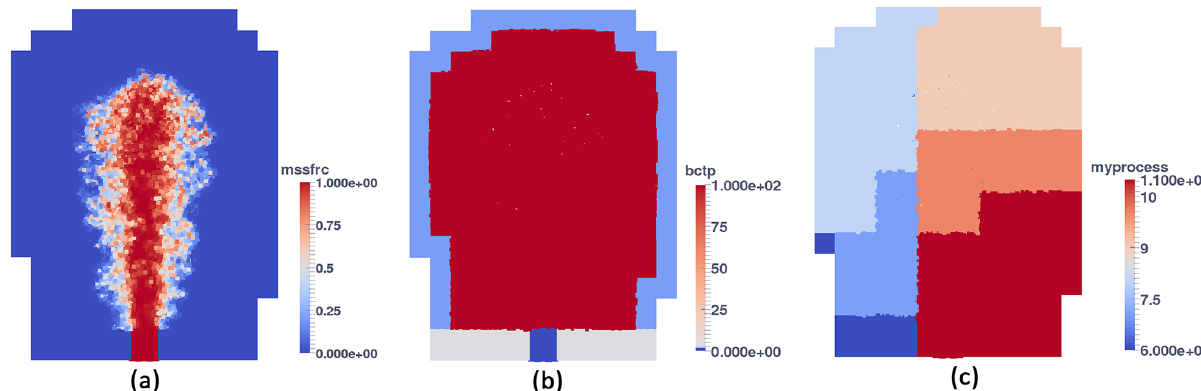
Figure 2. A cross-section view of the simulation domain in the y − z plane at 66s. Panel (a) shows the mass fraction. Panel (b) shows all boundary conditions: the dark blue region is occupied by eruption ghost particles with a “ghost particle ID” of 0; the light blue area is occupied by pressure ghost particles with a “ghost particle ID” of 1; the gray area is filled with wall ghost particles with a “ghost particle ID” of 2. The “ghost particle ID” of all real particles is set to 100; they occupy the major portion of the domain in panel (b) . Panel (c) shows the cross-section view of domain decomposition based on SFC. The simulation is conducted on 12 processors, so there are 12 subdomains in total. The cross-section view shows a portion of